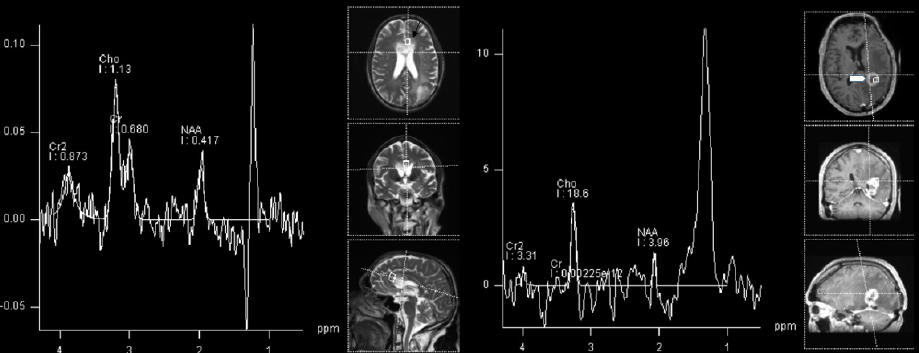
Figure 4. 1H-MRS in an adult patient with glioblastoma progression ( left , black arrow) and in a patient with signs of both progression and radiation necrosis ( right , white arrowhead). Cho/NAA ratio is under proposed cut-off for TP in progressive